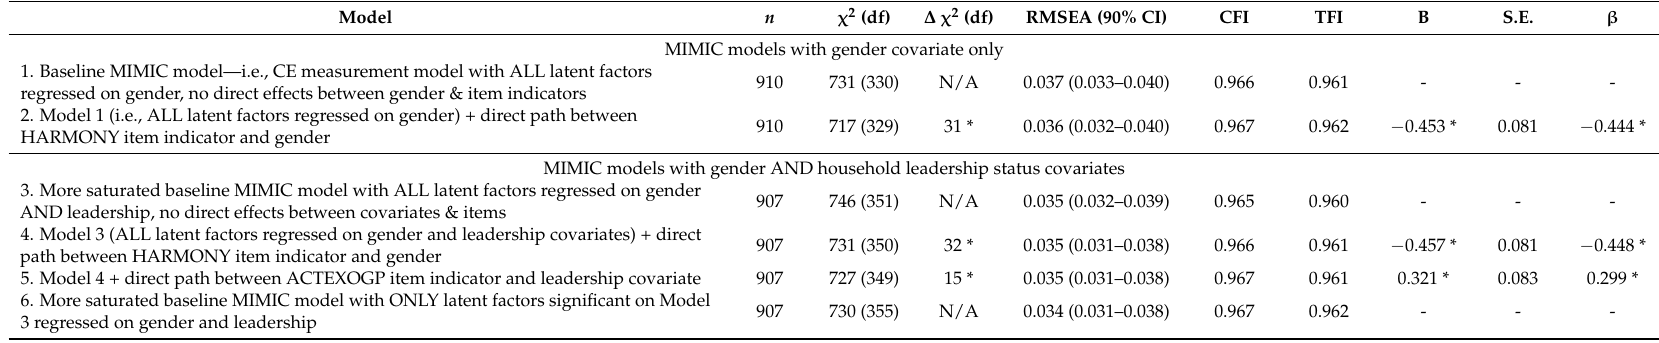
Table A6. Competing MIMIC Models: Fit Statistics, Unstandardised B Estimates, Standard Errors, and Standardised β Estimates. Model n χ 2 (df) ∆ χ 2 (df) RMSEA (90% CI) CFI TFI B S.E.